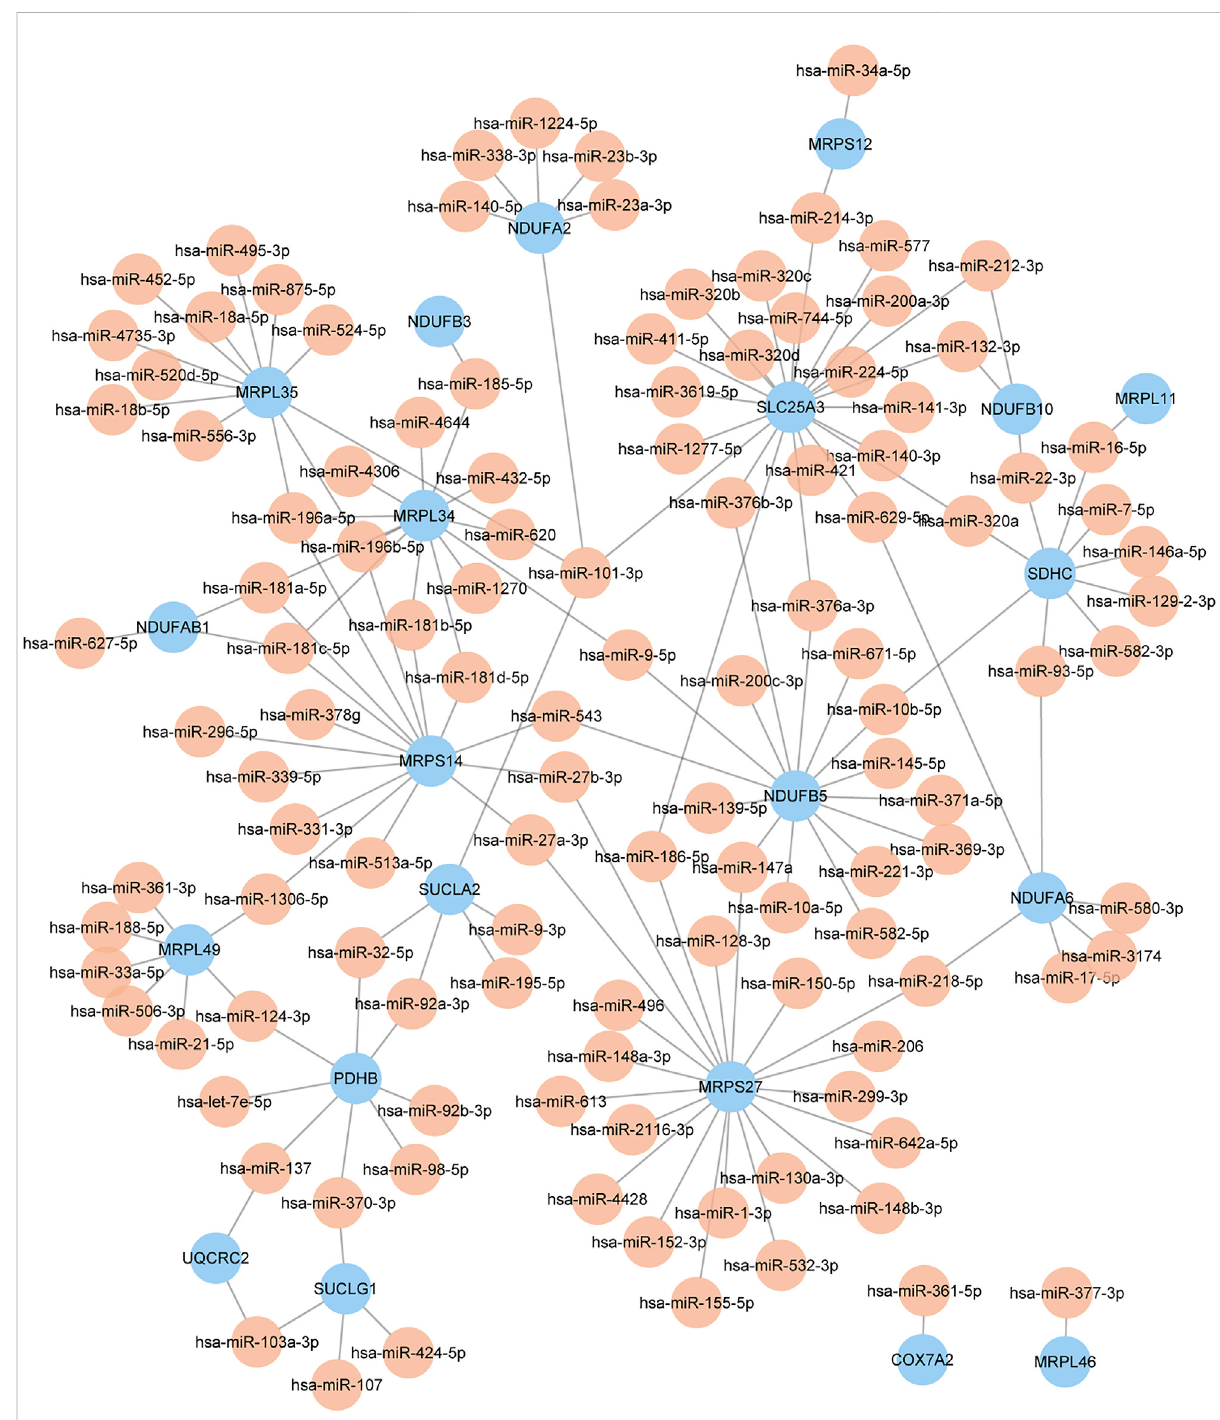
FIGURE 5 The miRNA-key gene network. Different colors of nodes represent different genes or miRNAs. The color yellow represents miRNA, and the color blue represents key